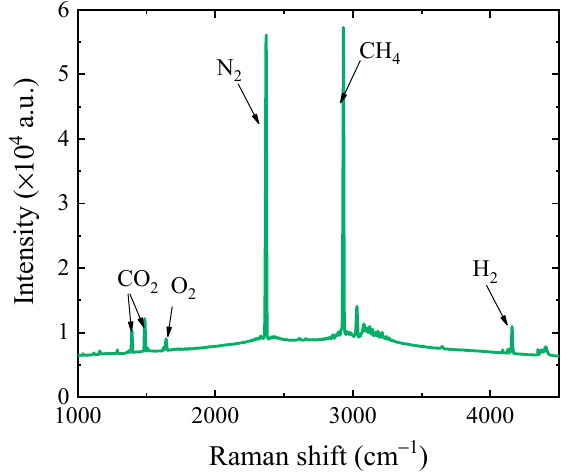
Figure 3. A typical detection result detected with the cavity enhanced Raman spectroscopy (CERS) probe.